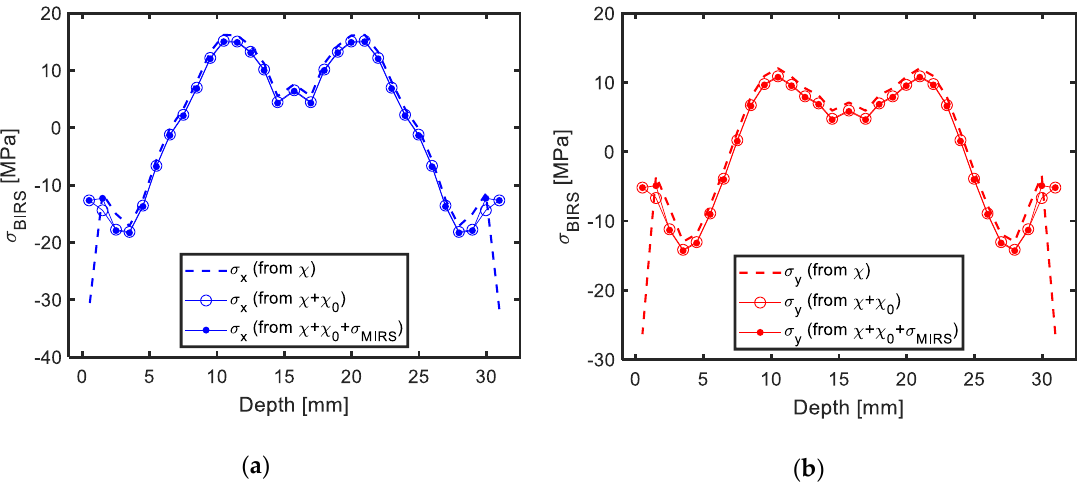
Figure 9. Measured BIRS profile considering only bulk or blank-initial residual stresses (BIRS), BIRS and initial deformation of the raw plate χ 0 , and BIRS, χ 0 and machining-induced residual stresses (MIRS): X direction( a ) and Y direction ( b ).